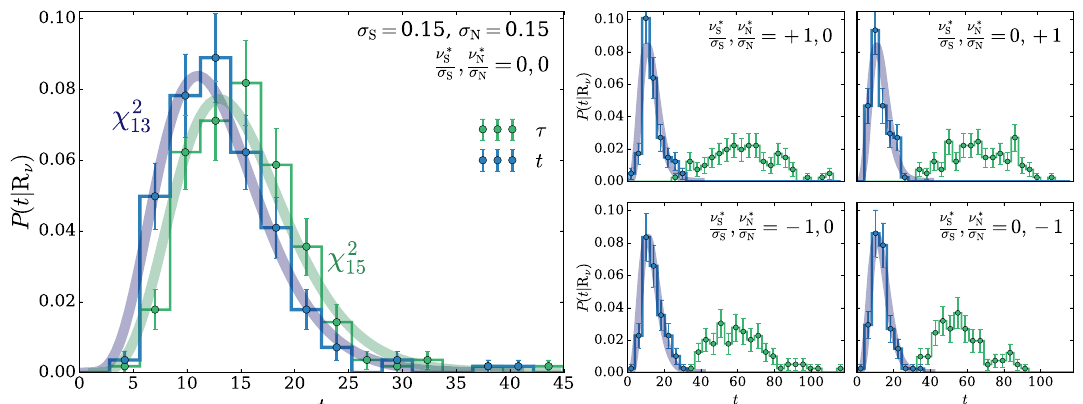
distribution is shown in green on the left 15